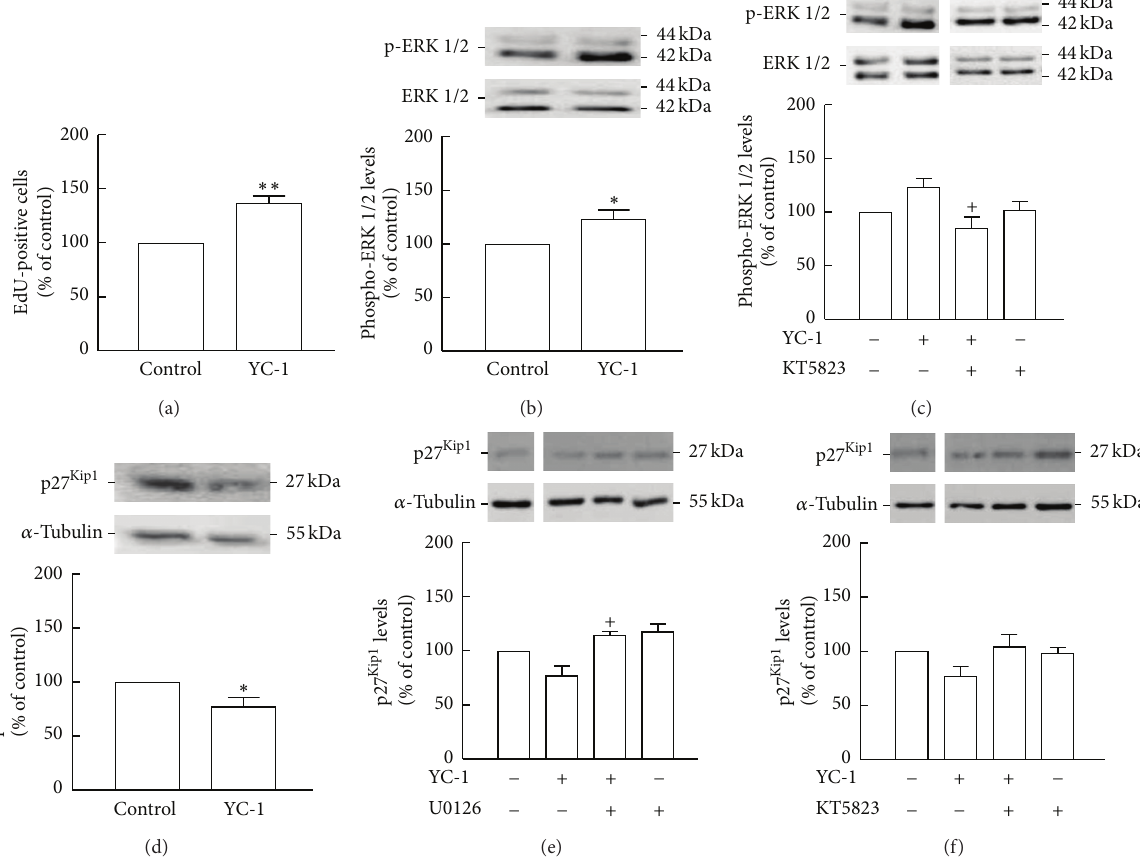
Figure 10: Activation of sGC stimulates proliferation of NSC, increases ERK1/2 phosphorylation, and decreases p2 7 Kip 1 levels. Cell proliferation following treatment with 20 𝜇 M YC-1 (a) for 24 h was assessed by the incorporation of EdU and analyzed by flow cytometry. Levels of phospho-ERK1/2 following treatment with 20 𝜇 M YC-1 (b) or YC-1 plus 1 𝜇 M KT5823 (c) and p2 7 Kip 1 levels following treatment with YC-1 (d) or YC-1 plus 1 𝜇 M U0126 (e) or KT5823 (f) for 2 h were assessed by Western blot. Representative images are shown. Data are expressed as means ± SEM of at least 4 independent experiments. (a), (b), and (d) two-tailed 𝑡 -test, ∗ 𝑃 < 0.05 and ∗∗ 𝑃 < 0.01 , significantly different from control and (c), (e), and (f) one-way ANOVA (Bonferroni’s post-test), + 𝑃 < 0.05 , significantly different from YC-1. sildenafil (106.4 ± 6.7%, 𝑃 > 0.05 ), or zaprinast (97.4 ± 4.8%, 𝑃 > 0.05 ) alone,